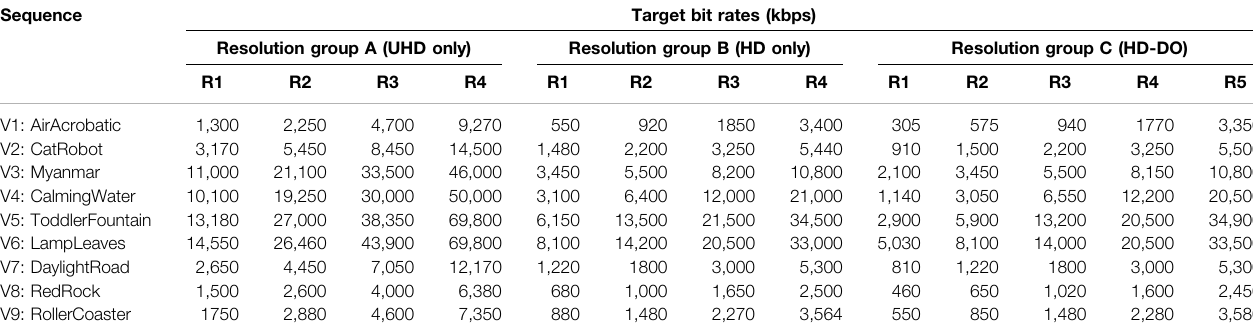
TABLE 4 | Pre-determined target bit rates for all test sequences in three resolution groups.